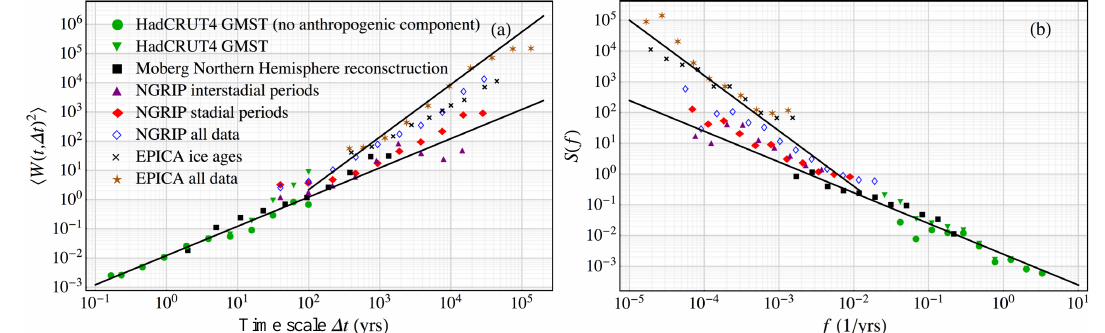
Figure 3. (a) For each time series considered in this paper we show double-logarithmic plots of the wavelet fluctuation (cid:104)| W ( t,(cid:49)t ) | 2 (cid:105) as a function of the timescale (cid:49)t . The green triangles and the green circles represent the HadCRUT4 monthly global mean surface temperatures with and without the anthropogenic component respectively. The black circles are the analysis of the Moberg Northern Hemisphere recon- struction. The analysis of the 20-year mean NGRIP data is shown as the blue diamonds, the purple triangles and the red diamonds. The blue diamonds show the results of the analysis of the entire data set dating back to 60kyrsBP. The red diamonds are the results of the analysis preformed on the stadial periods only, and the purple triangles are the results of the analysis of the interstadial periods only. The results for the EPICA ice core data are shown as the orange stars and the black crosses. The orange stars are obtained by analysis of the entire data set dating back 200kyrs, and the black crosses are obtained by only analysing the two most recent glaciations. The two solid lines have slopes β = 1 and β = 1 . 8. (b) As in (a) , but instead of the wavelet fluctuation function we show the spectral density function S ( f ). The two solid lines have slopes − β with β = 1 and β = 1 .